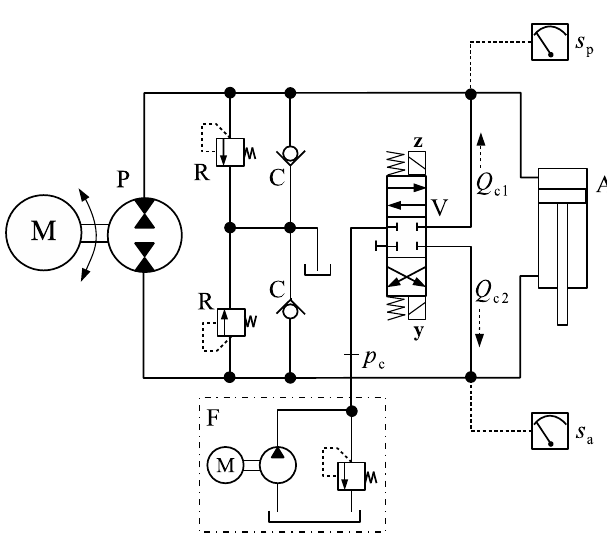
Figure 30. Circuit with logic-controlled flow compensation.